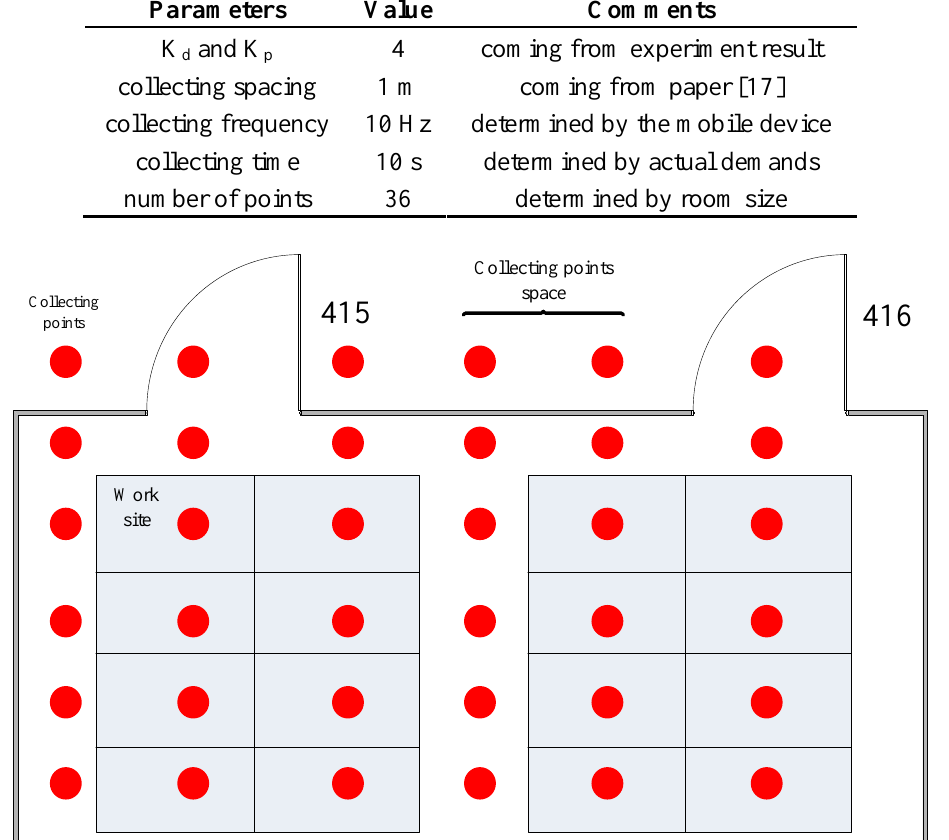
Figure 4. Distribution of collecting